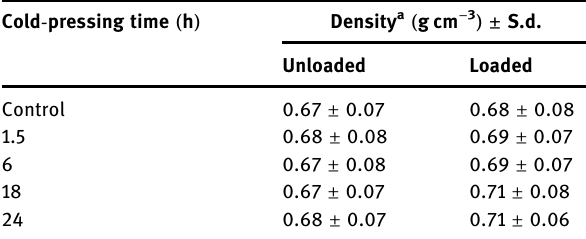
Table 5: Average value of density